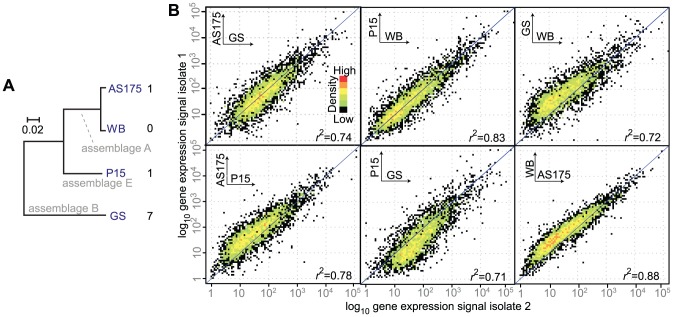
Pairwise comparisons of global transcription levels.(A) Phylogenetic relationship of the four studied isolates. The phylogeny was inferred from 10 concatenated protein-sequences of each genome. The data set was aligned with ClustalW v2.1, and a neighbor-joining tree was constructed using MEGA v.5 [71]. The tree is based on the conceptual translations of the following protein-coding genes (only WB locus-tags are shown; prefix GL50803_): 16936, 31340, 15039, 16445, 14972, 16747, 16681, 9072, 17112, and 11384. The scale bar shows the number of substitutions per site. The name of the isolate is shown in blue at the tip of the branches, and the assemblage (genotype) is shown in light grey. Numbers to the right indicate the number of differentially expressed genes compared to the other isolates. (B) Pairwise correlations of global transcription levels. Each dot represents a conserved four-way ortholog. The x- and y-axes show gene expression of isolate 1 and 2 (log10-scaled FPKM; values incremented by 1 before transforming). The colors represent overlap in the plot, i.e. black means a single gene and red means higher plotting density.